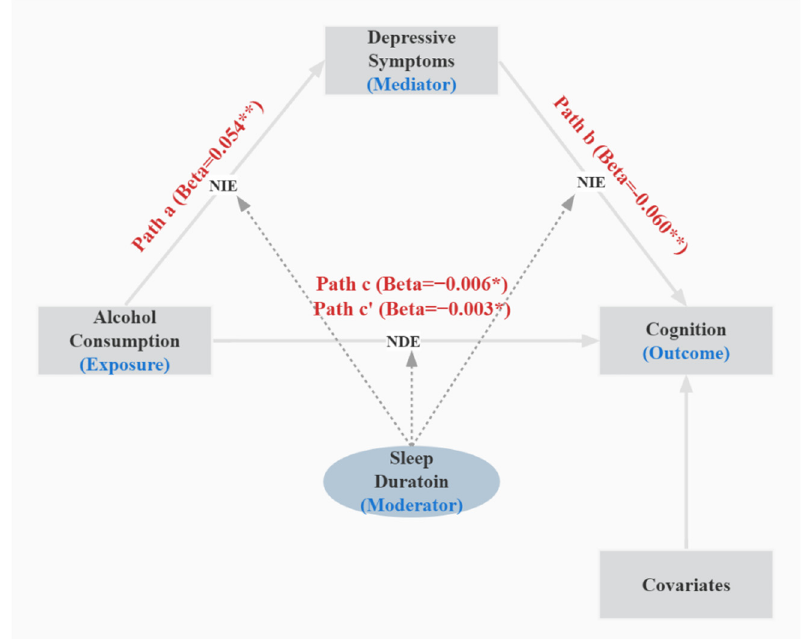
Figure 4. The model of conditional indirect effect via depressive symptoms when sleep duration was used as a moderator. After adjusting for gender, age, body mass index, blood pressure, education level, marriage, cigarette consumption, self-reported hypertension, diabetes, dyslipidemia, coronary heart disease, stroke, chronic lung disease, and asthma. Abbreviations: NIE, natural indirect effect; NDE, natural direct effect. Path a = exposure predicting mediator; path b = mediator predicting outcome; path c = exposure predicting outcome; path c’ = exposure predicting outcome. Beta = standardized regression coefficient. * p < 0.05 ** p < 0.01.